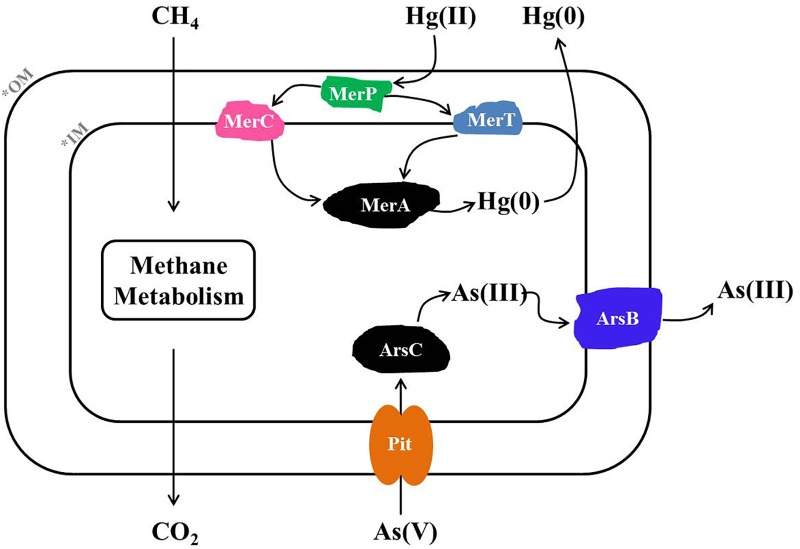
Metabolic pathway of Hg(II) and As(V) reduction inferred from the HL18 genome sequence. OM, outer membrane; IM, inner membrane; MerA, mercuric reductase; MerT, mercuric transport protein MerT; MerC, mercuric transport protein MerC; MerP, mercuric transport protein periplasmic component; Pit, phosphate transporter; ArsC, arsenate reductase; ArsB, arsenic efflux pump protein.